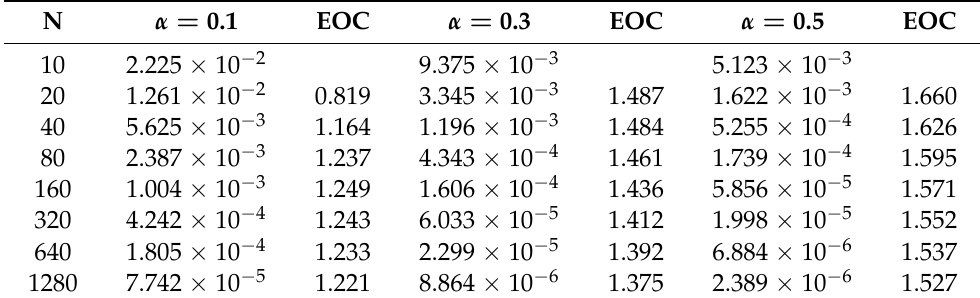
Table 3. Table showing the maximum absolute error and EOC for solving (53) using the predictor– corrector method for 0 < α ≤ 0.5.